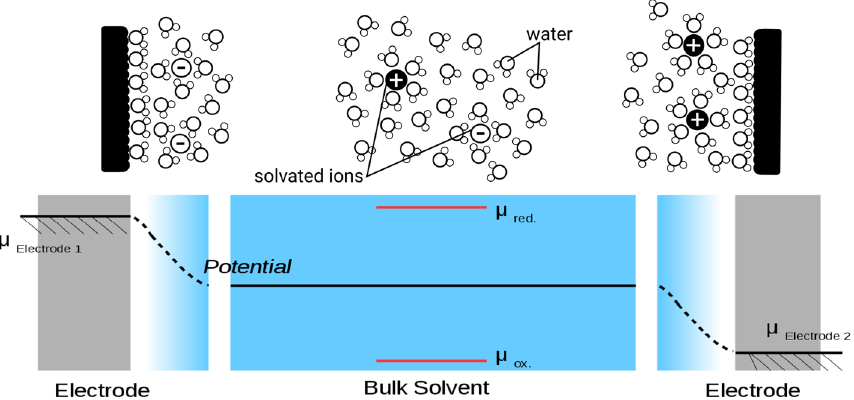
Fig. 5. – Schematic microscopic picture of solvent/ion distribution at the electrochemical inter- face and in the solvent (top). Potential distribution in the electrochemical cell